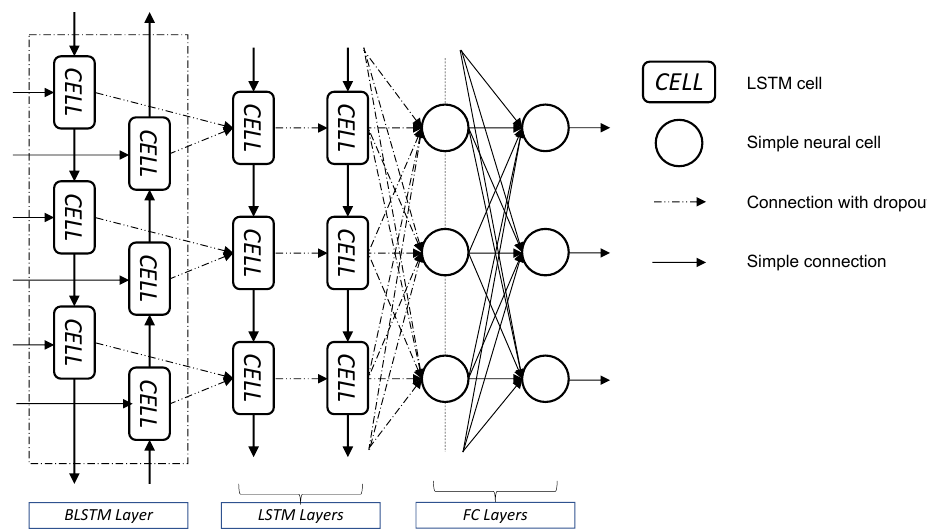
Figure 3. Deep Artificial Neural Network (dANN)